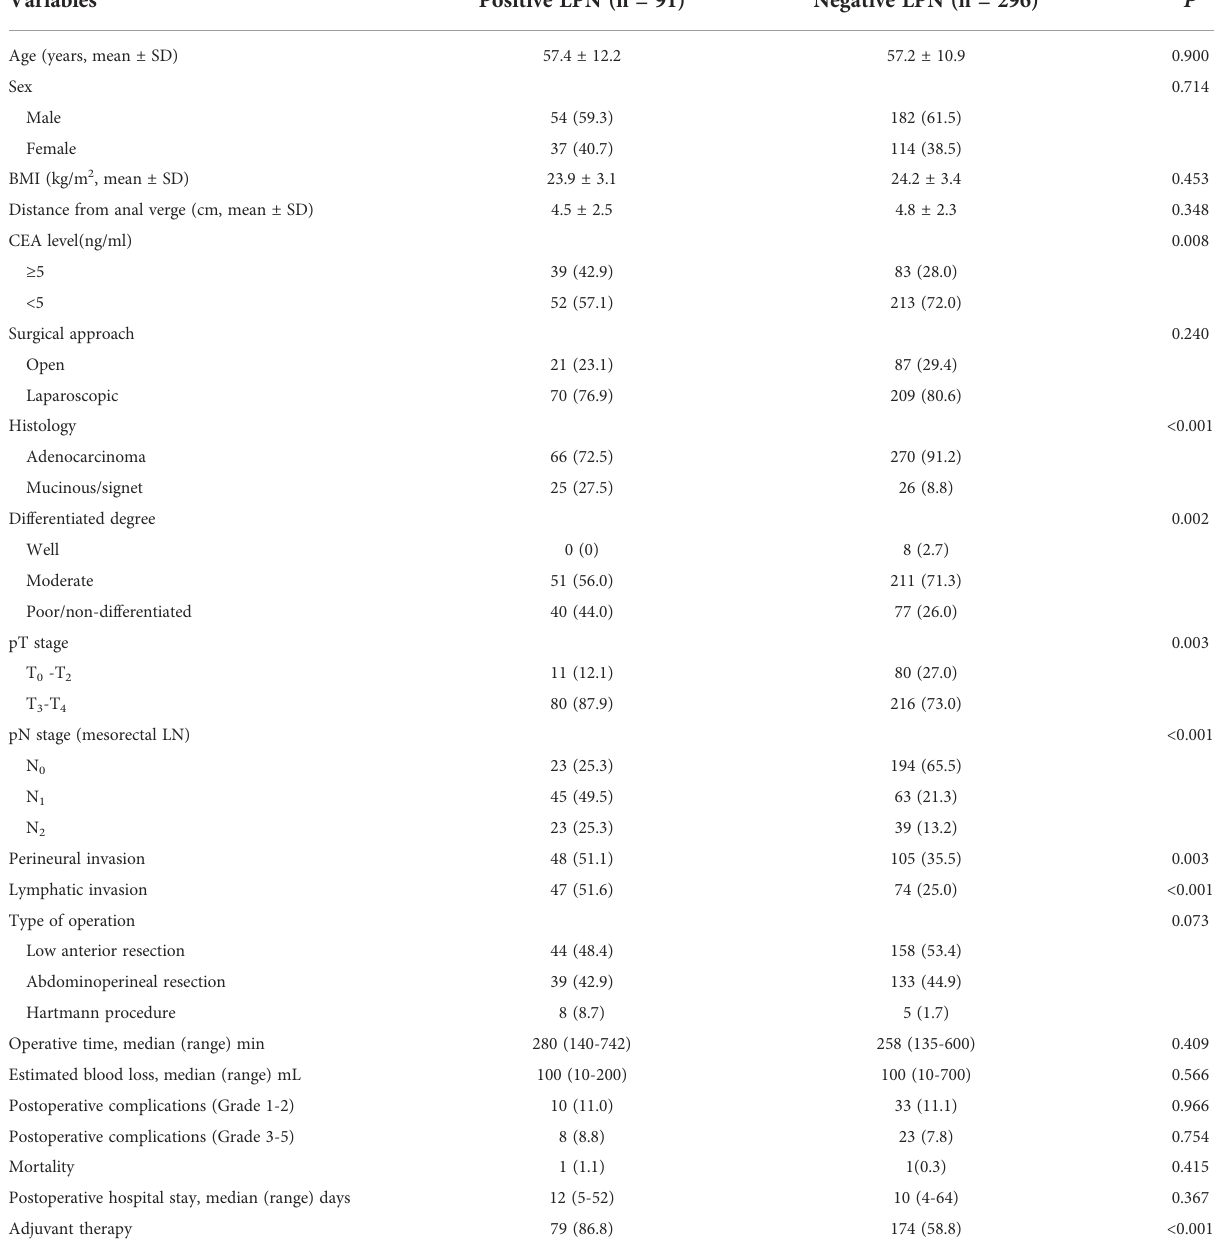
TABLE 1 The baseline data and clinicopathological